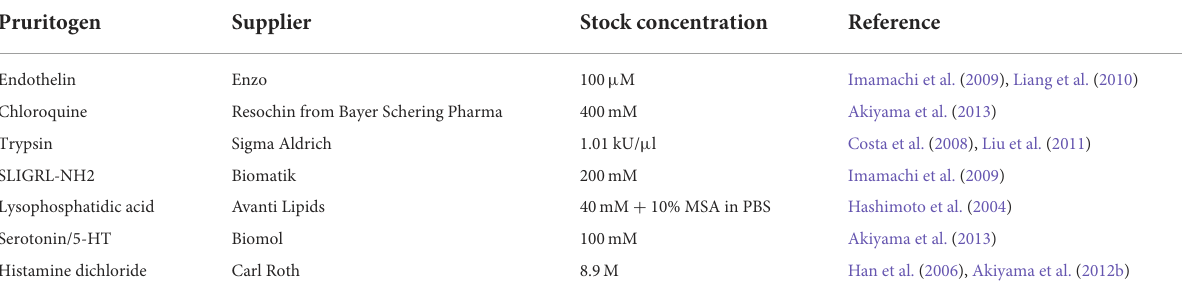
TABLE 1 Stock concentration and provider information for the